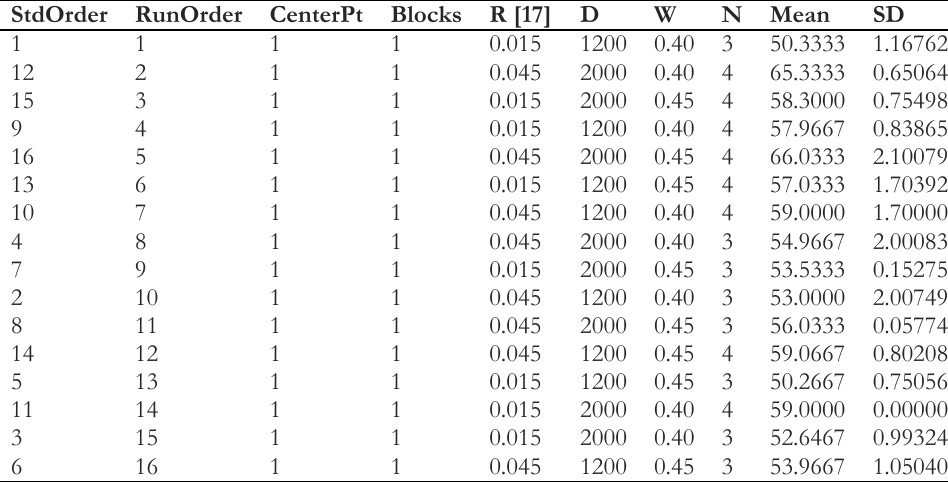
Table 4. Mean and SD of